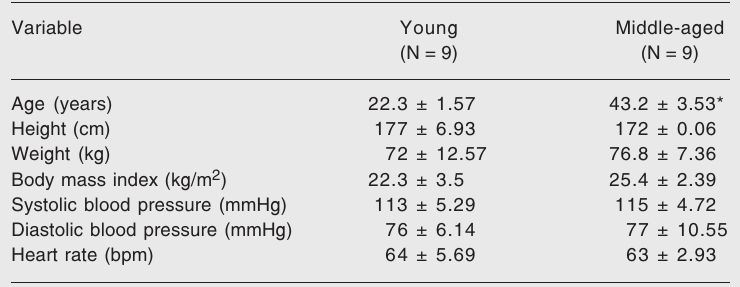
Data are reported as means ± SD. *P < 0.05 compared to young subjects ( t